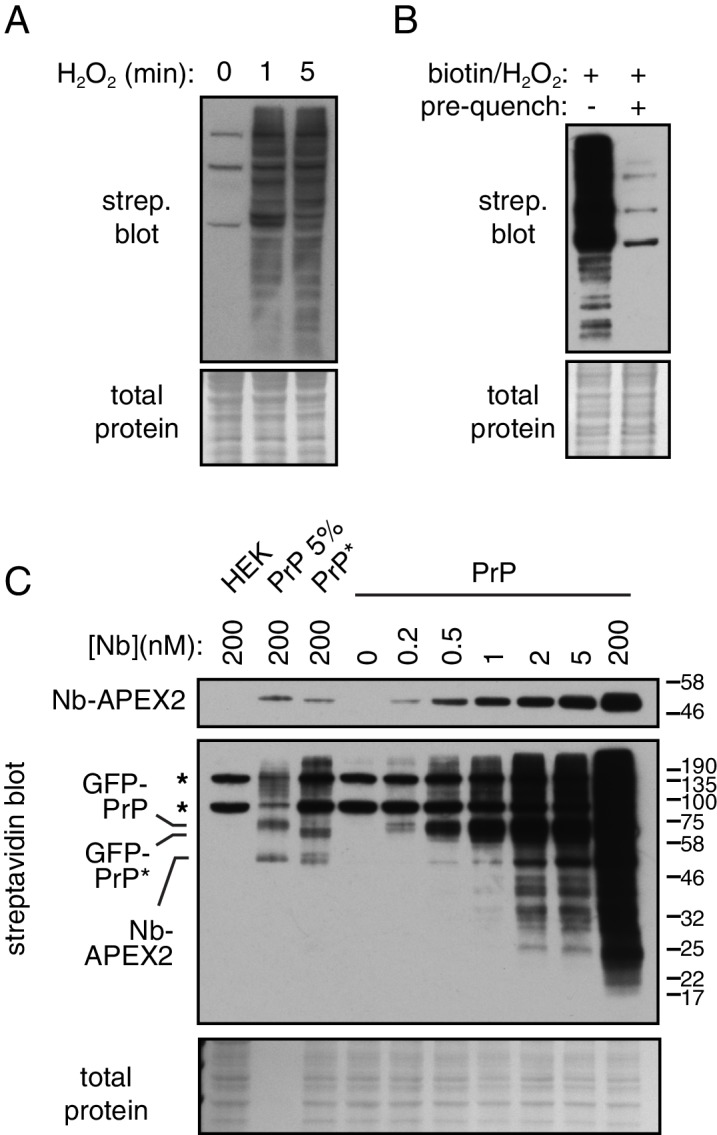
Characterization of APEX2-mediated biotinylation.(A) Cells expressing GFP-PrP were surface labeled with 200 nM Nb-APEX2, washed, and incubated with biotin-phenol and H2O2 for the time indicated prior to quenching. Cell lysates were analyzed for biotinylated proteins by blotting with streptavidin-HRP. The few prominent bands seen at the 0 time point are endogenous biotin-modified proteins. (B) Cells expressing GFP-PrP surface labeled with 200 nM Nb-APEX2, washed, incubated with biotin-phenol and H2O2 for 1 min, then quenched (first lane). Alternatively, the quenching solution was added prior to addition of biotin-phenol and H2O2 for 1 min (second lane). The cells were then lysed and analyzed for biotinylated proteins by blotting with streptavidin-HRP. Note that if cells are pre-quenched, no biotinylated proteins are observed beyond the few endogenous biotin-modified proteins. (C) Cells expressing GFP-PrP and GFP-PrP* were surface labeled with Nb-APEX2 added at the indicated concentrations to the medium, washed, then incubated with biotin-phenol and H2O2 for 1 min. For comparison, HEK293 cells are shown as a negative control. The positions of the most prominently labeled proteins (Nb-APEX2 and its target antigen) are indicated.